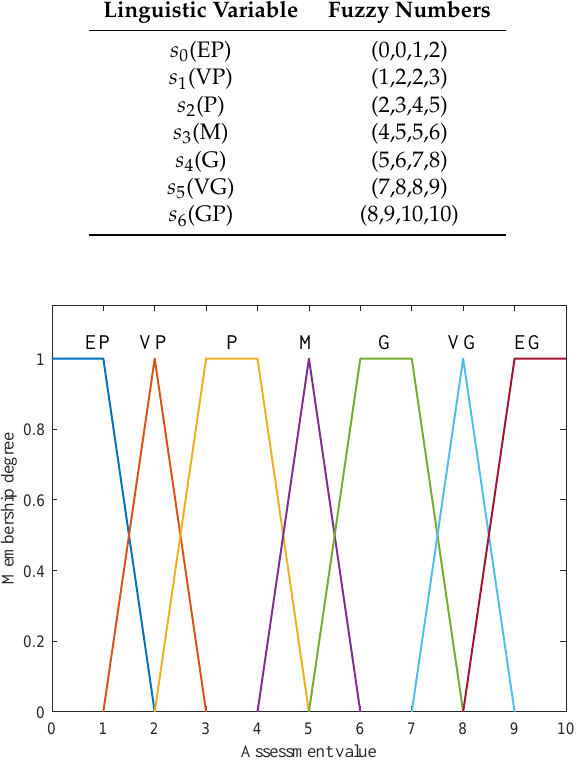
Figure 6. The geometric representation of linguistic variables in Table 18 including extremely poor (EP), very poor (VP), poor (P), medium (M), good (G), very good (VG), extremely good